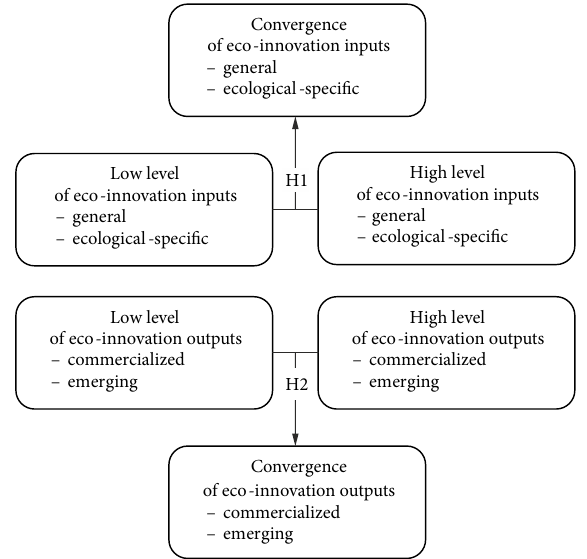
Figure 1. The conceptual model of